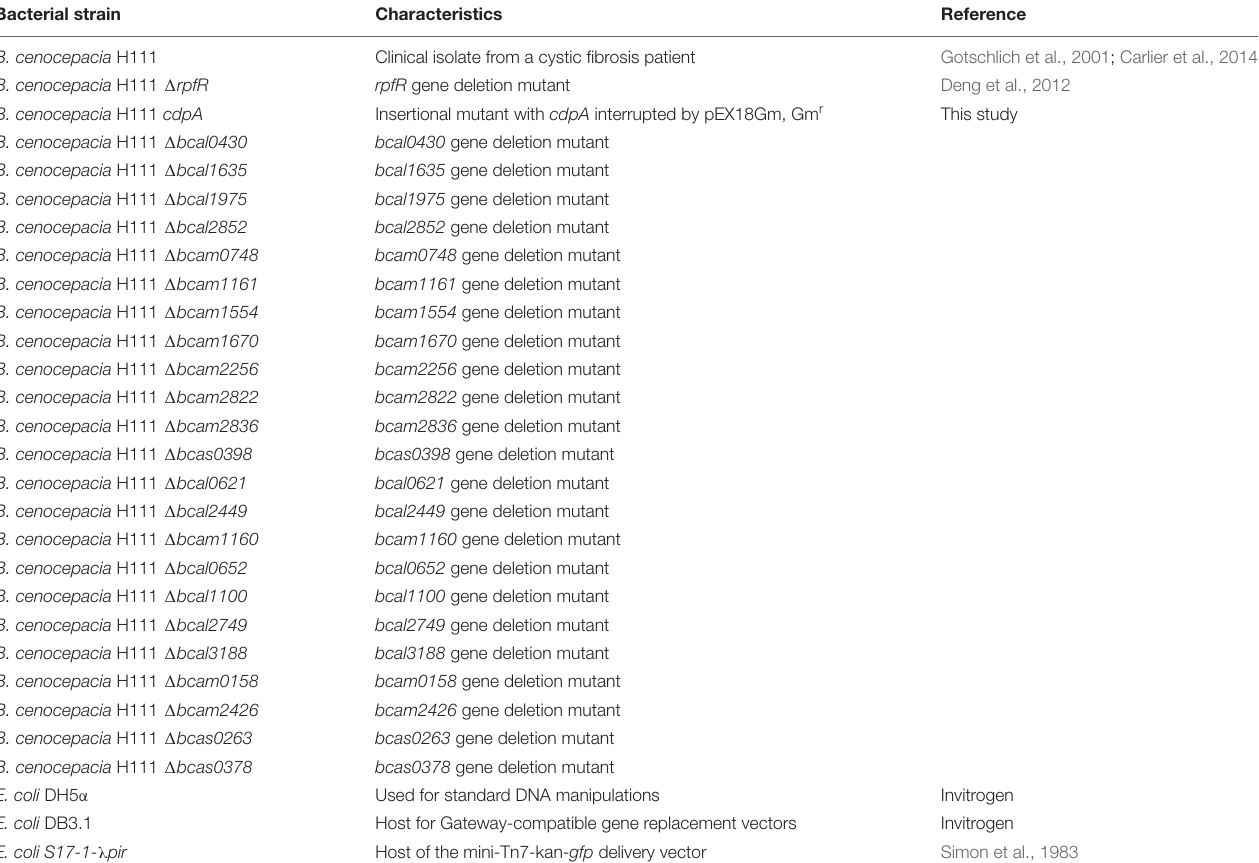
TABLE 1 | Bacterial strains used in this